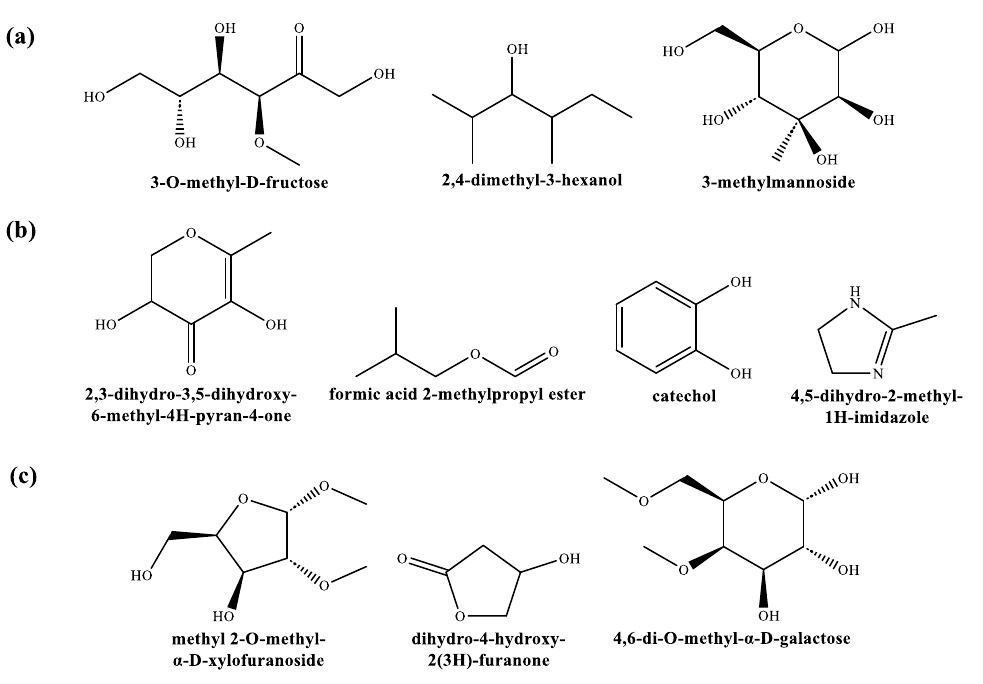
Figure 3. Chemical structures of several of the main constituents of ( a ) G. biloba leaf; ( b ) sarcotesta; and ( c ) sclerotesta extracts. and ( c ) sclerotesta